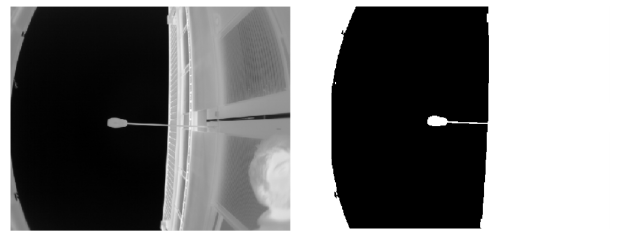
Figure 5. Infrared original image ( left ), sky segmentation based on Otsu threshold ( right